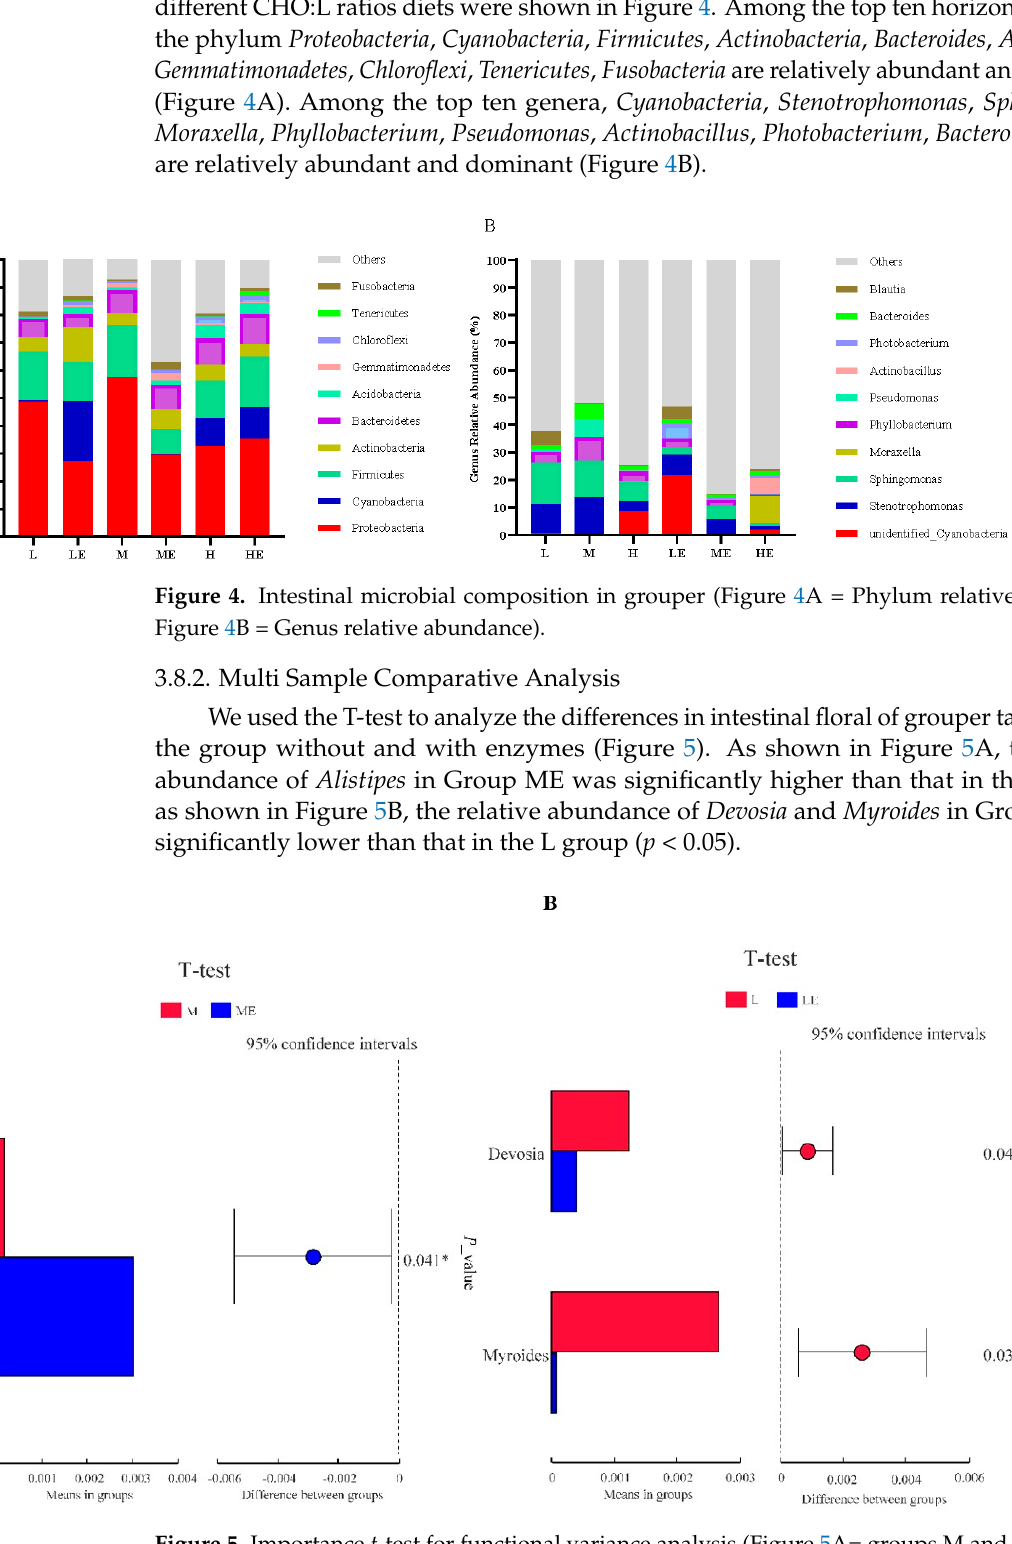
Figure 3. Effects of carbohydrase supplementation on glut2 mRNA expression in hybrid grouper fed different CHO:L ratios diets (Figure3 A = Liver glut2 expression; Figure3 B = Intestine glut2 ex- pression). Data represent means of three fish in each group; error bar indicates S. D. Average of different superscripts in the same column (a, b, c, d, etc. Or A, B, C, etc. Or X, Y) are significantly different ( p < 0.05) . (Dietary CHO:L ratio = A, B, C, etc.; Dietary carbohydrase = X, Y); no means no enzyme, have means enzyme.